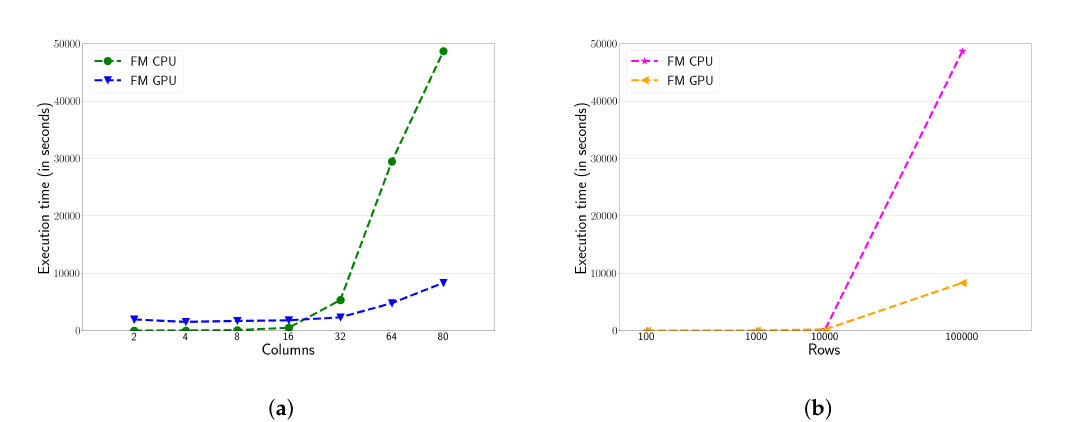
Figure 3. Execution time (in seconds) of Fuzzy Minimals (FM) algorithm for the first ( a ) and second ( b ) experiment on the HPC platform, comparing both CPU and GPU